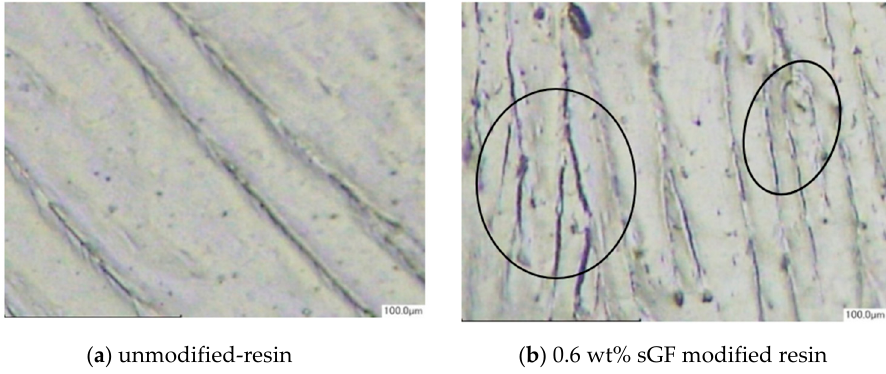
Figure 19. The number of cycles to failure of composite reinforced by 25 mm carbon fiber length under cyclic loading.